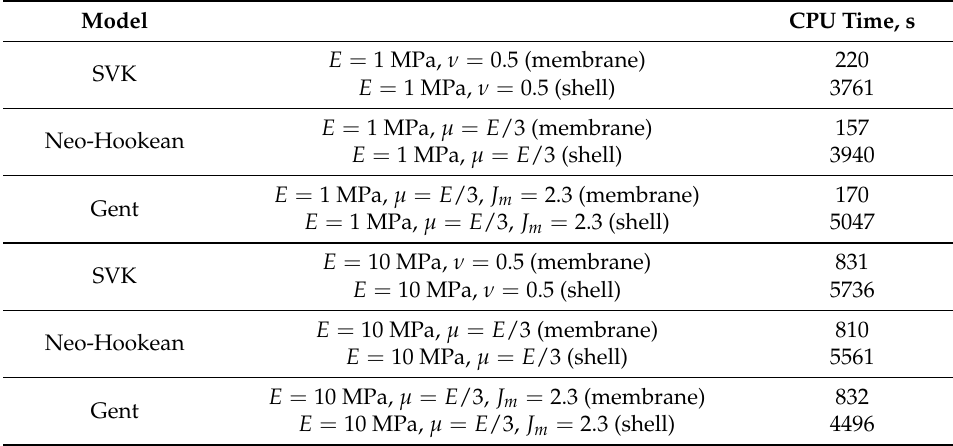
Table 2. CPU times for different models on the coarse